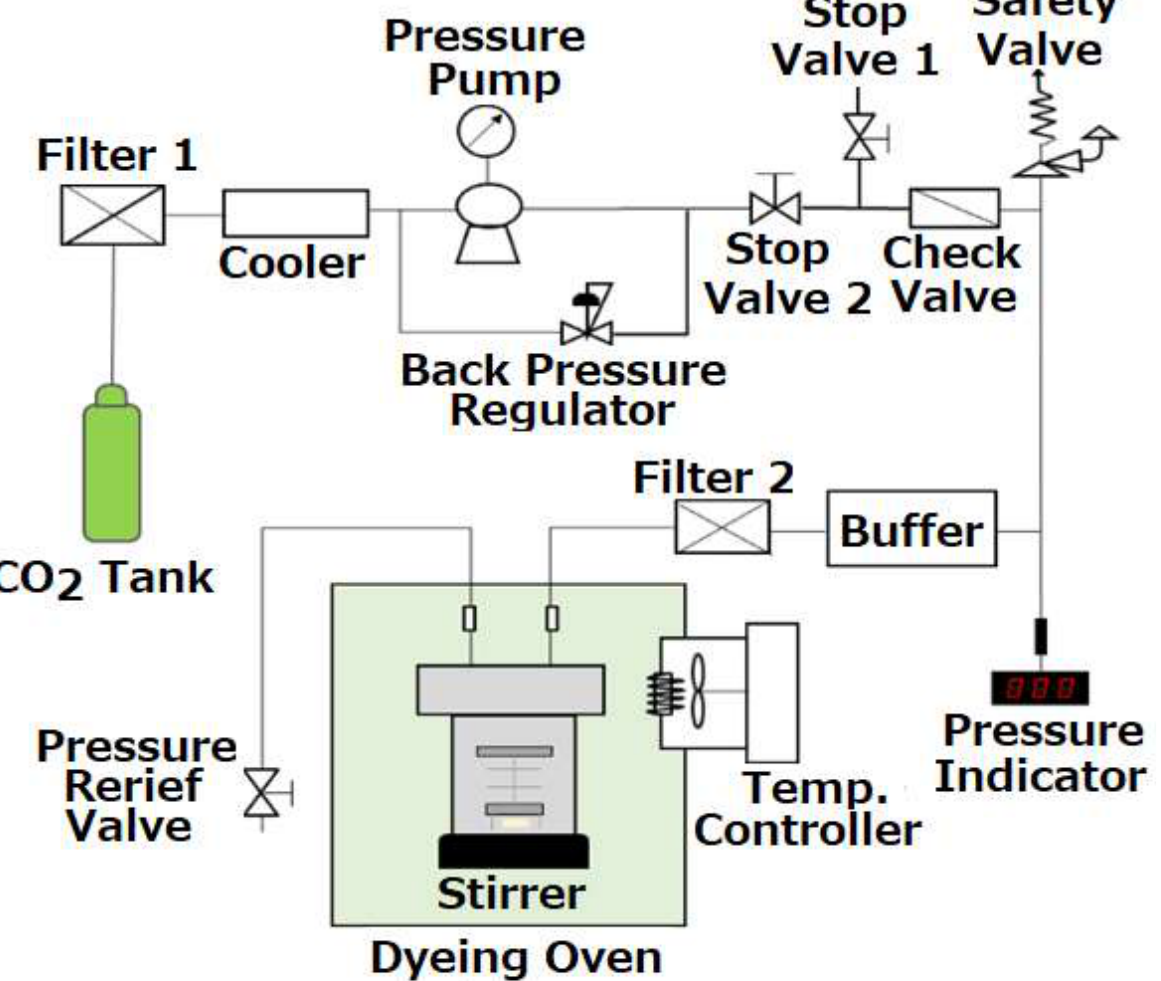
Figure 2. Supercritical carbon dioxide dyeing apparatus.